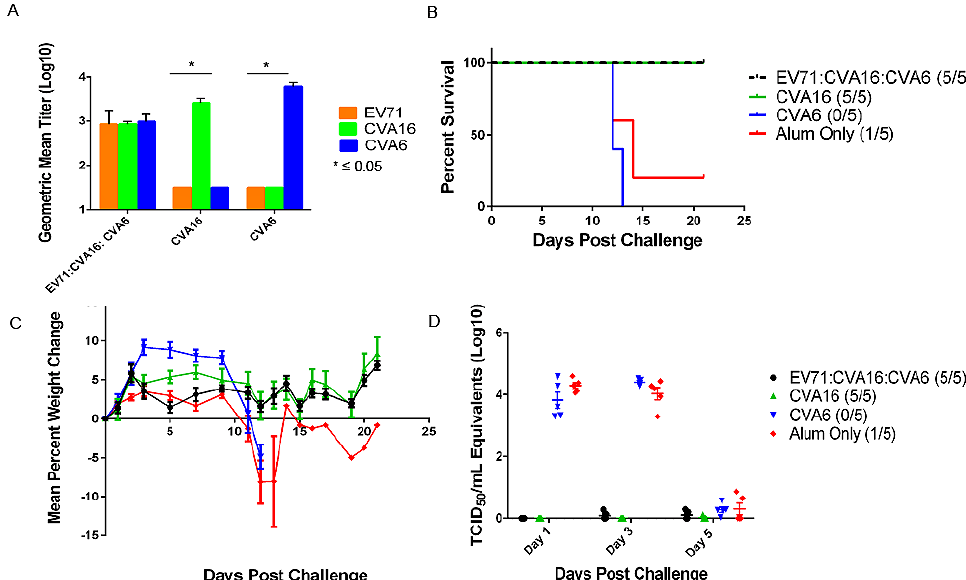
Figure 4. Monovalent CVA16 and trivalent EV71:CVA16:CVA6 vaccines provided complete protection to challenge with mCVA16 in 10 week-old AG129 mice. ( A ) Microneutralization assays were performed on serum collected on day 14 post boost against EV71, CVA16, and CVA6. Each